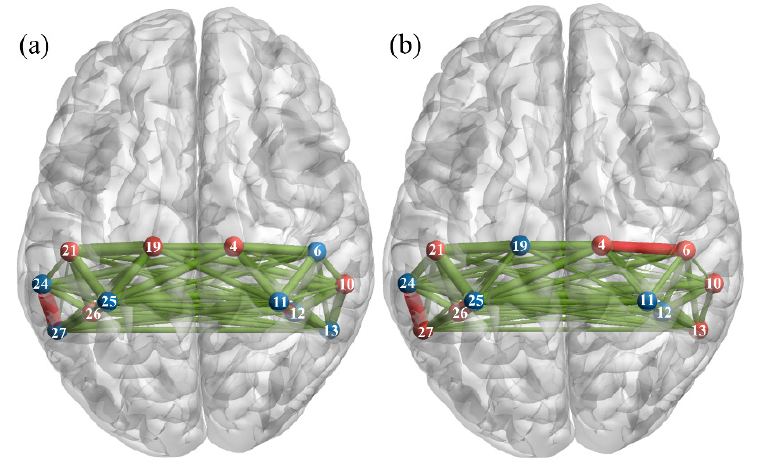
Figure 2. Mean connectivity during ( a ) Action-Execution, ( b ) Action-Observation. The edge thick- ness represents the connectivity strength. Red edge, node: connections which have significantly greater